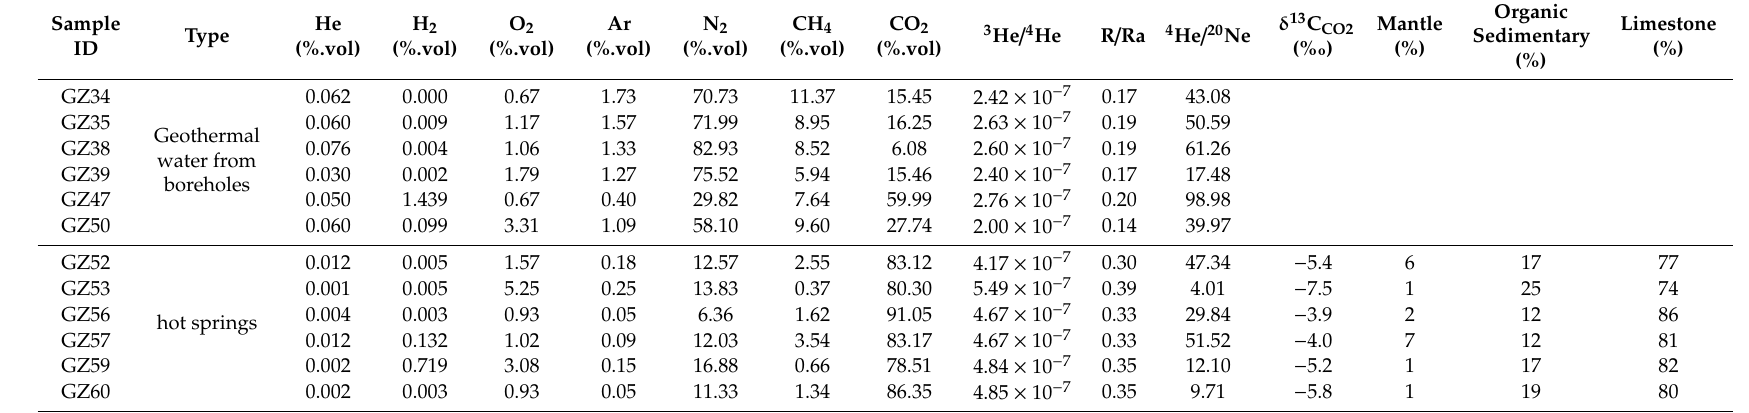
Table 2. Volume fraction, isotope composition of gas samples and the contribution ratio of limestone, mantle and organic sedimentary for CO 2